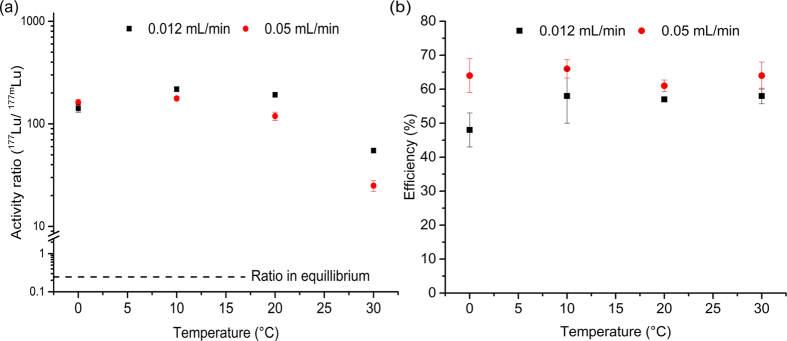
Effect of temperature and flow rate on efficiency.(a) Effect of temperature on the177Lu/177mLu activity ratio at different flow rates ( 0.012 mL/min and  0.05 mL/min). (b) Effect of temperature on the efficiency of separation at different flow rate ( 0.012 mL/min and  0.05 mL/min).